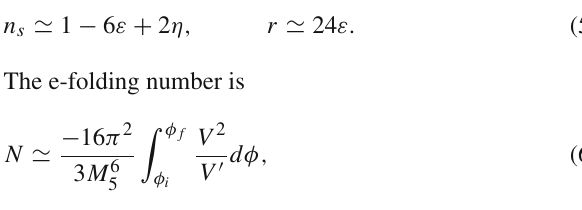
Fig. 2 Confrontation between the theoretical predictions of standard inflation with the Planck TT, TE, EE + low E + lensing data with 68% and 95% CL (shaded regions) [6]. The convex inflaton potentials lie above the n = 1 line, while the concave inflaton potentials lie below it In standard inflation, we have the following results